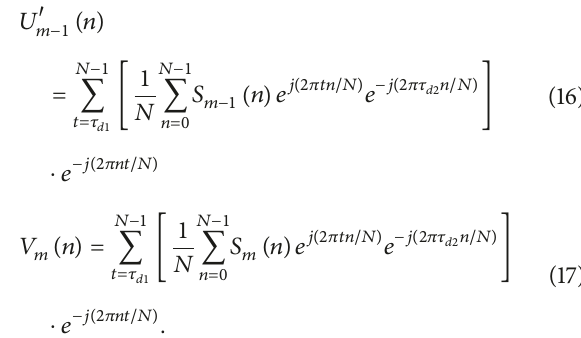
data block and 𝑚 th GI of the delay wave overlap with 𝑚 th data block of the direct wave. This signal distribution is shown in Figure 7. Since some of 𝐶 𝑚 (𝑛) have a negative value, a symbol error occurs.